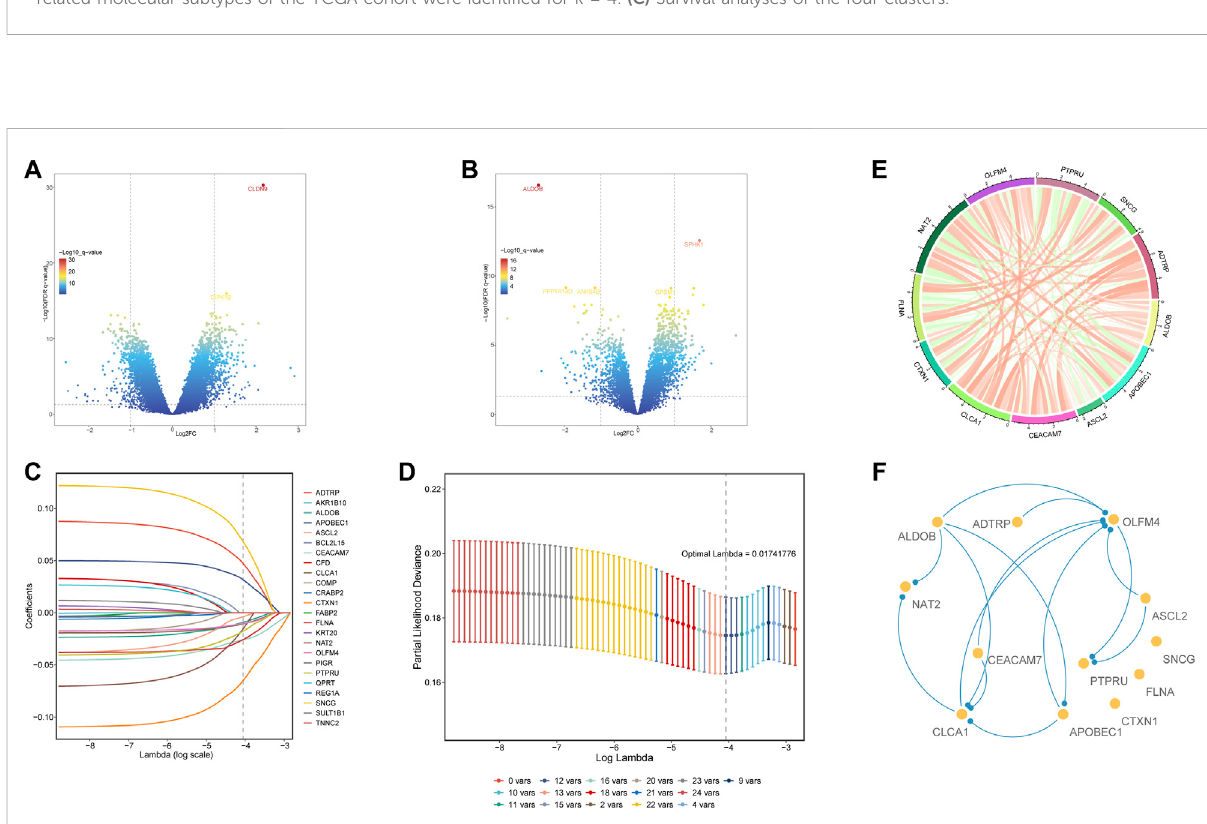
FIGURE 3 Differential expression and analysis of glycolysis- and lactate-related genes among the four clusters. (A) DEGs between clusters 1 and 2. (B) DEGs between clusters 3 and 2. (C) LASSO coef fi cient pro fi le of twelve OS-related glycolysis- and lactate-related genes. (D) Optimal tuning parameter of glycolysis- and lactate-related genes. (E) Gene expression correlations of twelve OS-related glycolysis- and lactate-related genes. (F) PPI network analysis of twelve OS-related glycolysis- and lactate-related genes.